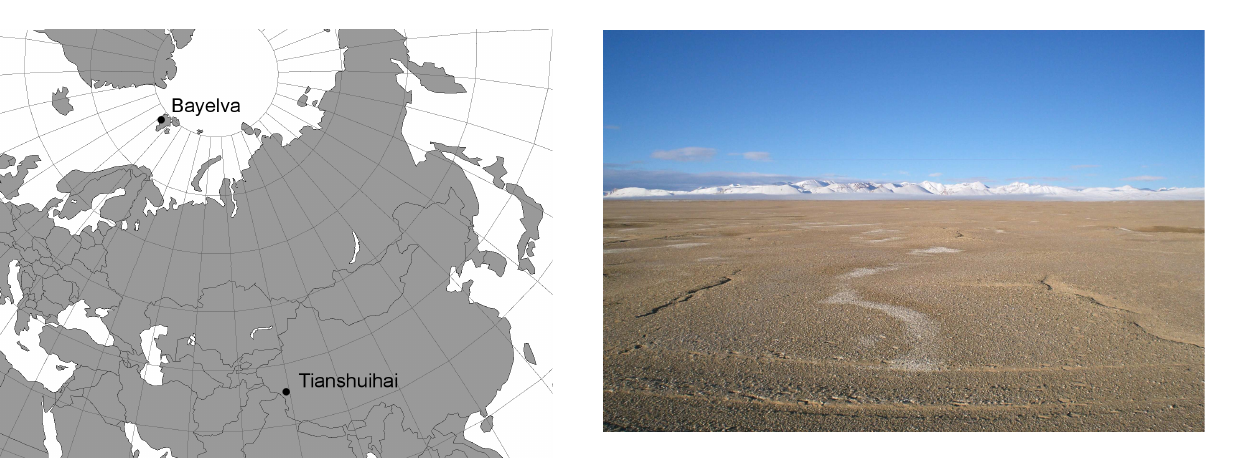
Fig. 3. Overview over the sedimentary plain at the Tianshuihai sta- tion.